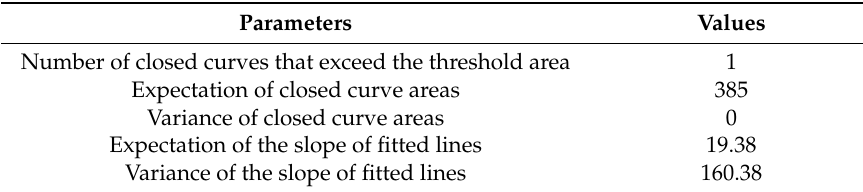
Figure 8. Impedance diagram for extraction of the characteristic parameters. Table 2. Characteristic